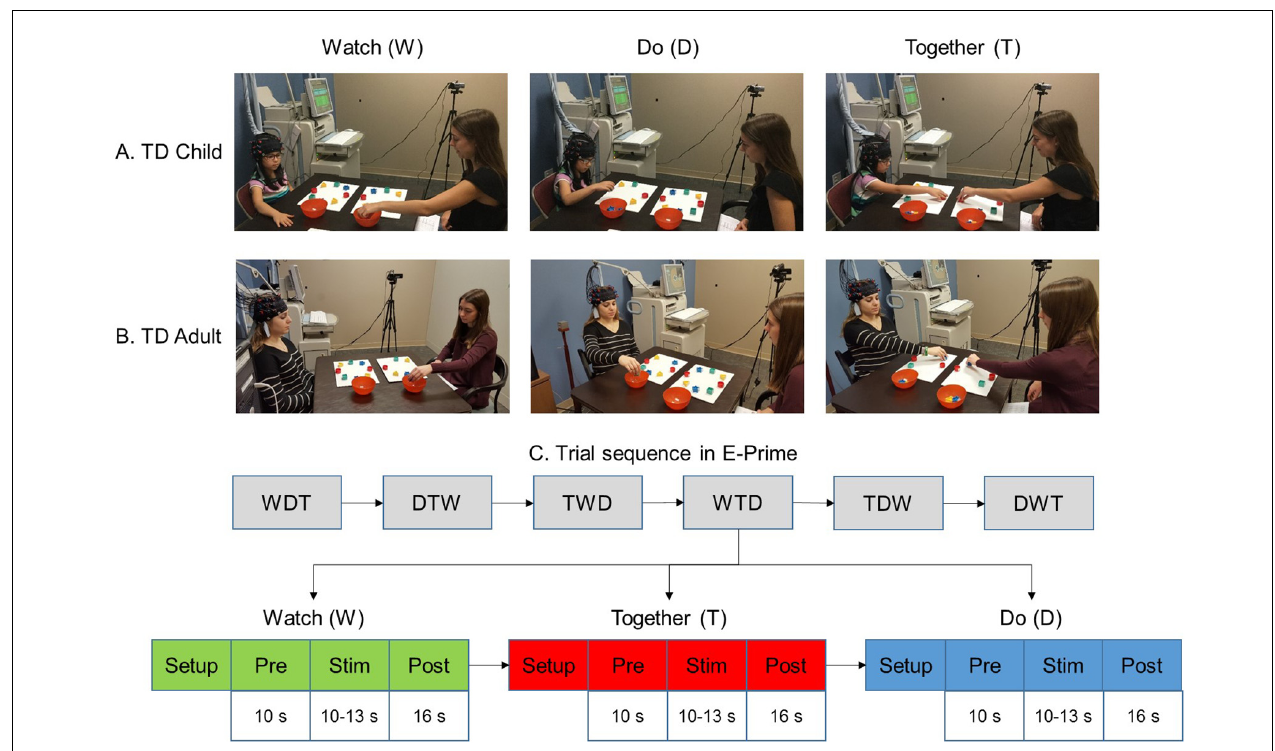
FIGURE 1 | Experimental setup (A,B) and task sequence (C) . Written permission for publication of participant pictures has been